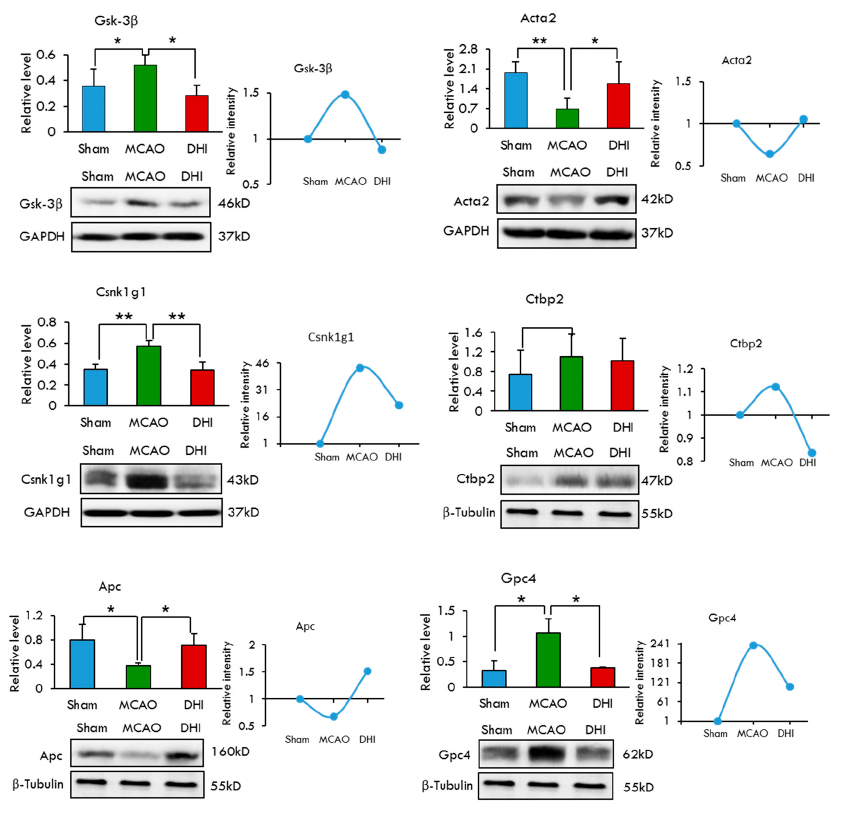
Figure 4. Selection and validation of the six candidates from the WNT signaling pathway for the hippocampus after cerebral ischemic injury and repair by Western blot. The results of Western blotting of the six differentially displayed hippocampus proteome proteins were analyzed with a statistical method (one way ANOVA and multiple testing) by SPSS (Table 3). We show the trends of protein abundance, either from Western blotting or from the label-free